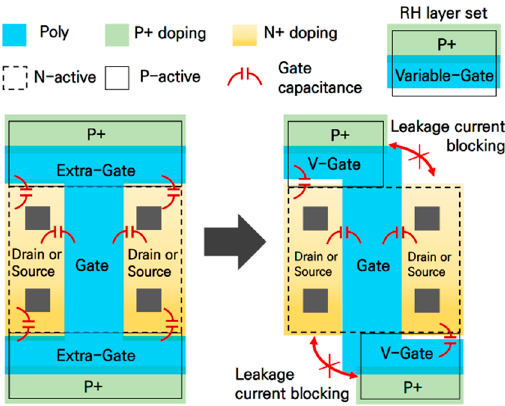
Figure 7. Structural diagram of the improved radiation-hardened (RH) variable-gate n-MOSFET.